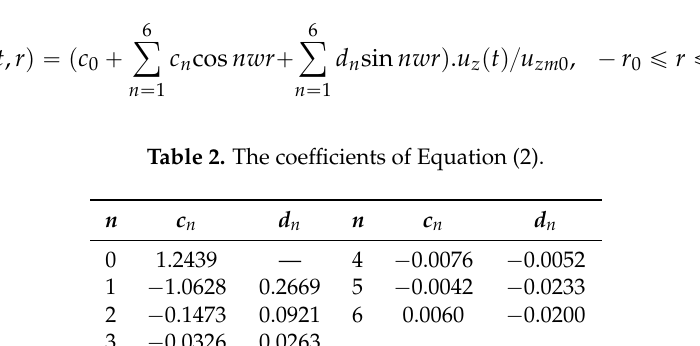
Figure 7. The relation curve of vibration amplitude and radial position of particles.